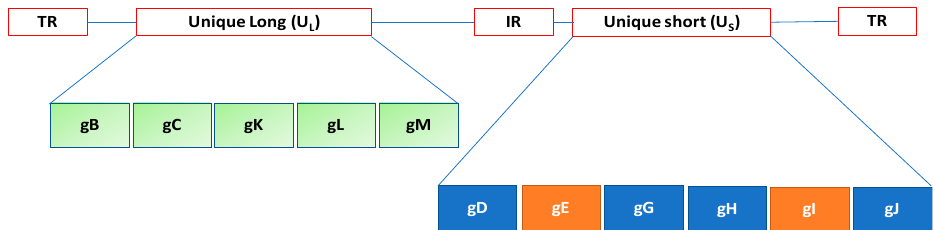
Figure 1. The genome structure of herpesviruses comprises two regions designated Unique Long (U L ) and Unique Short (U S ). Terminal repeat (T R ) and Internal repeat (I R ) sequences may bracket unique sequences of both L and S or only S. Each region encodes different envelope glycoproteins.